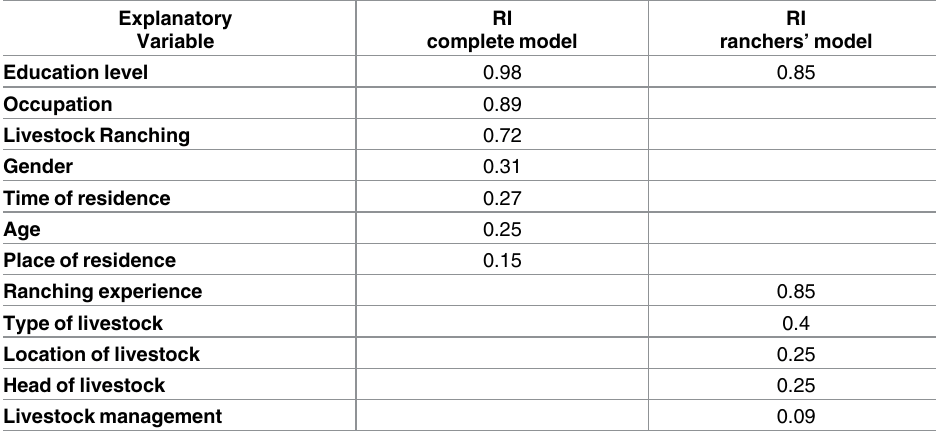
Table 4. Relative importance (RI) of explanatory variables used to explain social perception on the Andean condor for all people and for a subset of data composed only by